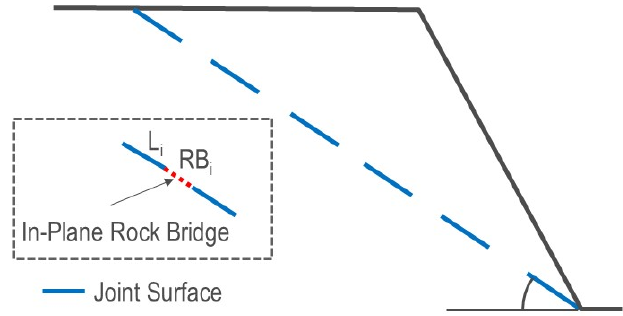
Figure 3. Simple slope problem introducing the problem of rock bridges according to the definitions